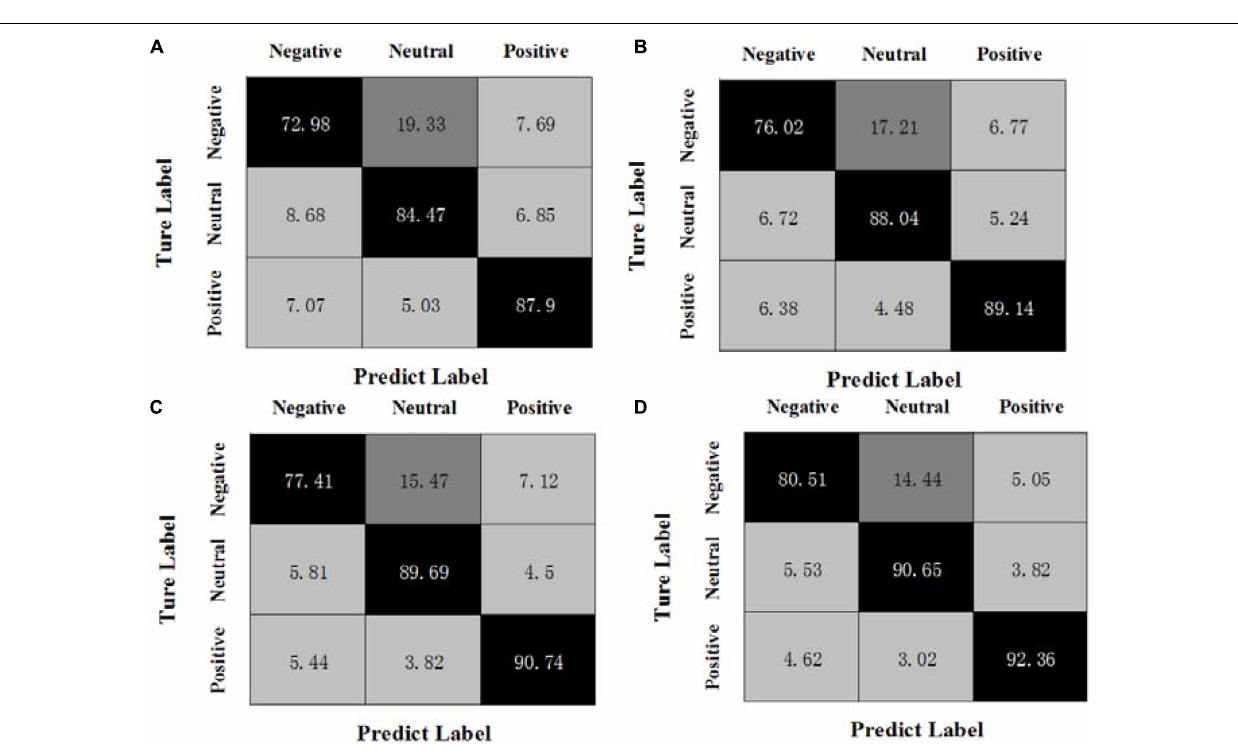
Frontiers in Aging Neuroscience |